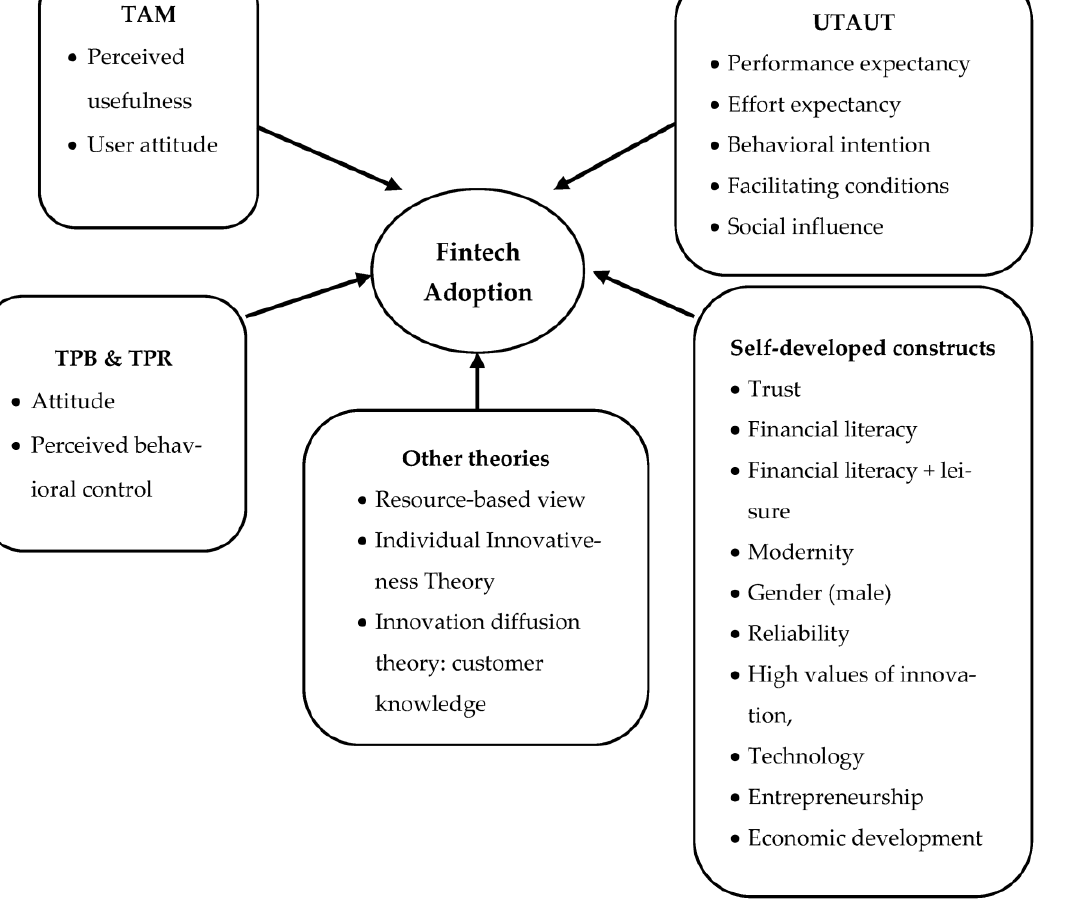
Figure 3. The proposed framework of fintech adoption determinants in literature.